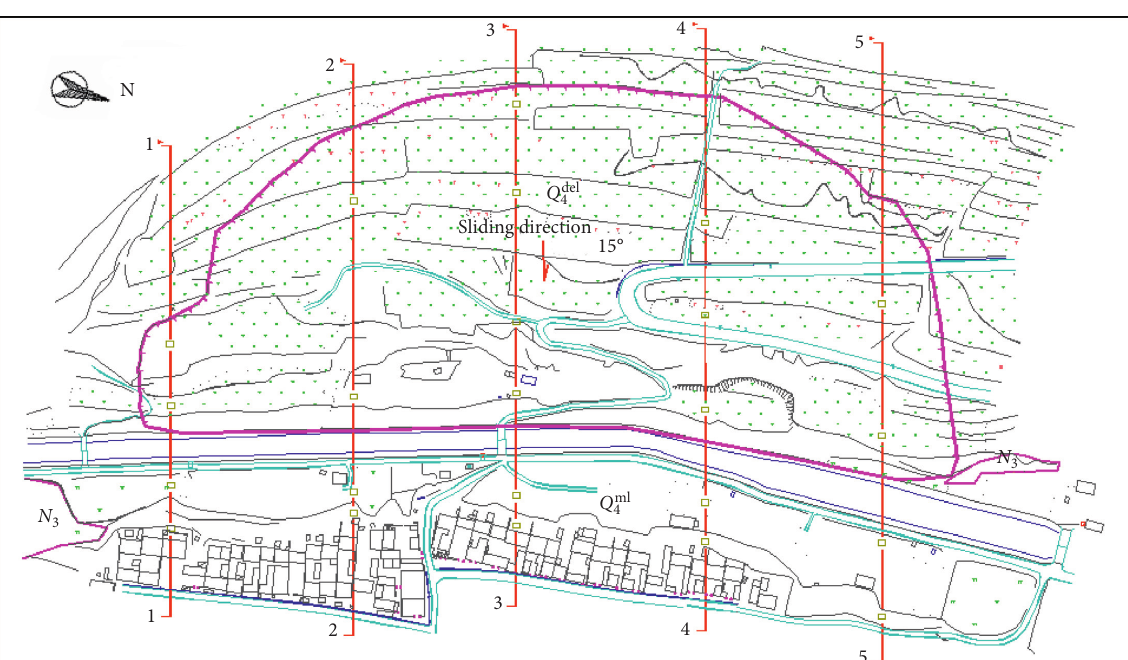
Figure 2: The location and plan of the landslide